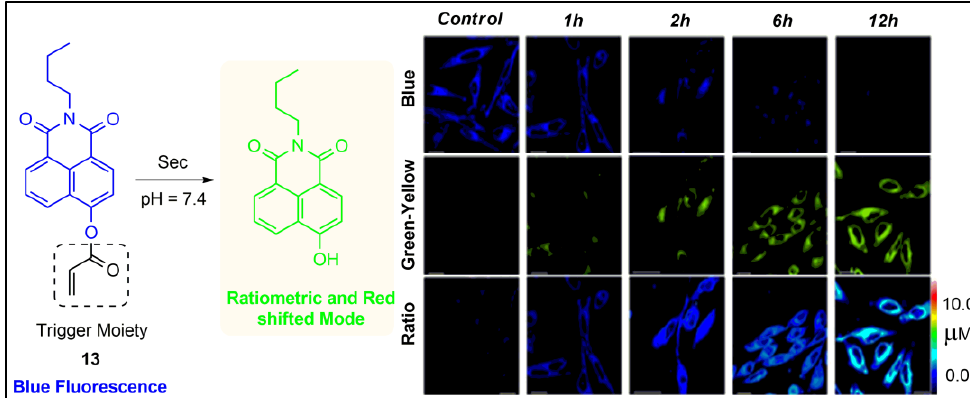
Figure 13. Proposed sensing mechanism for Sec activation of 13 . The in situ fluorescence changes of Hela cells stimulated to Na 2 SeO 3 (5 μM) for different times (1, 2, 6, 12 h), and then incubated with 13 (5 μM). Adapted with permission from [72]. Copyright (2017) The Royal Society of Chemistry.